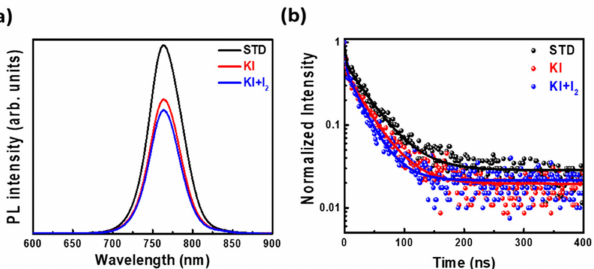
Figure 6. The ( a ) PL and ( b ) TRPL analyses of perovskite films on TiO 2 /FTO glass with various